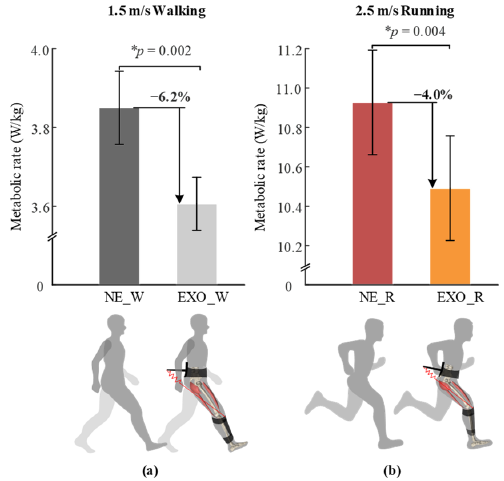
Figure 5. The average net metabolic rate in ( a ) walking and ( b ) running conditions. NE_W, EXO_W, NE_R and EXO_R represent walking with no exoskeleton, walking with exoskeleton, running with no exoskeleton and running with exoskeleton conditions, respectively. The asterisk (*) indicates the statistical difference between the two tested conditions using two-sided paired t -test.